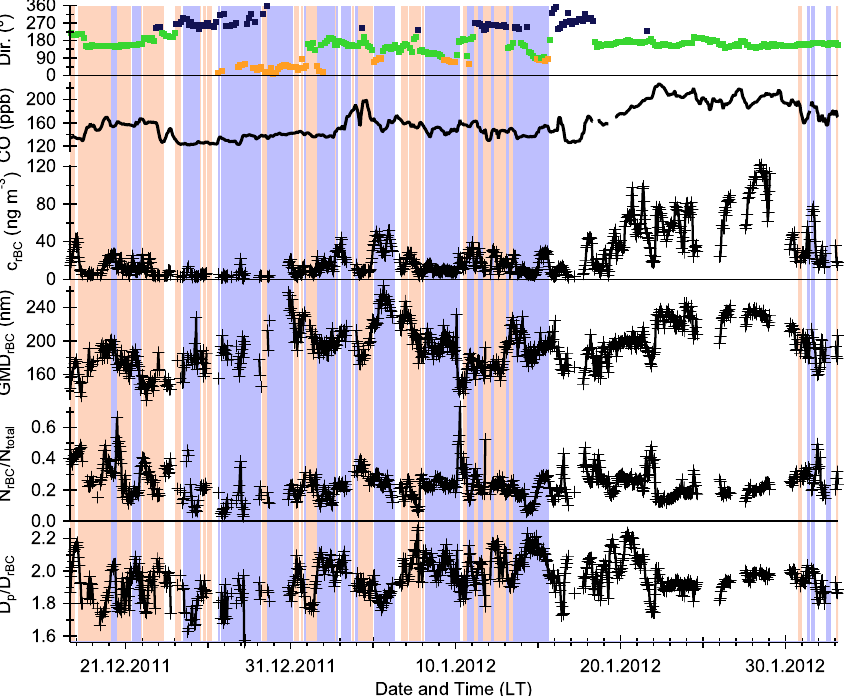
Figure 3. Time series of hourly averages of average trajectory direction (the color is based on three sectors: Arctic Ocean (orange) 0– 90 ◦ , continental Europe (green) 90–225 ◦ and North Atlantic (black) 225–360 ◦ ), carbon monoxide (CO) concentration, total rBC mass concentration ( c rBC ), geometric mass mean diameter (GMD rBC ), the fraction of 350–450nm particles containing rBC ( N rBC /N total ), and particle to rBC core diameter ratio for 150–200nm rBC cores ( D p /D rBC ). Blue background color indicates that the station was in cloud, red means no clouds and white means variable conditions or missing